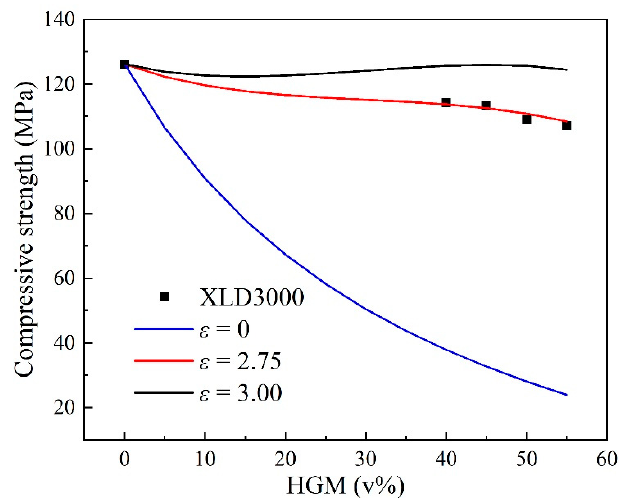
Figure 3. The curves of the compressive strength with the volume fraction for AG-80 epoxy resin-based buoyancy materials. Table 5. The mechanical properties of composites with different volume fraction HGMs.